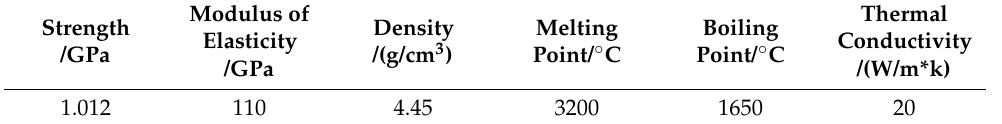
Table 2. Material properties of TC4.